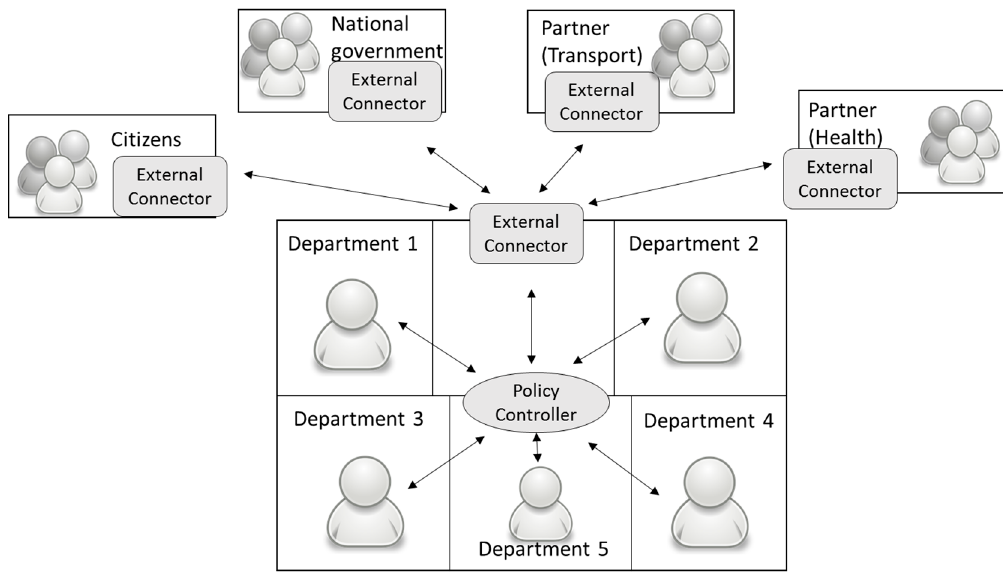
Figure 13. Simulation Approach.